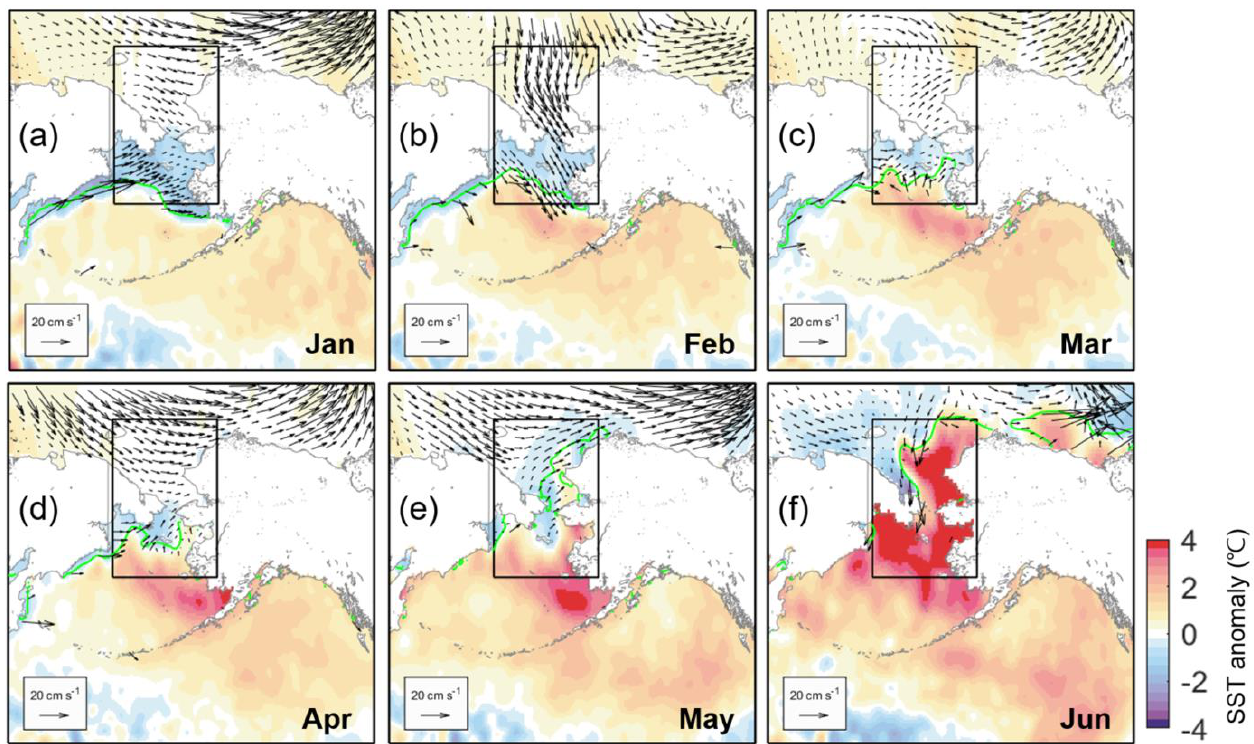
Figure 8. Basin-scale distribution of monthly SST anomaly (color shading) during January – June 2019, including monthly sea ice motion (vector). The box indicates our study area. The green lines denote the marginal ice edge (SIC = 15%).